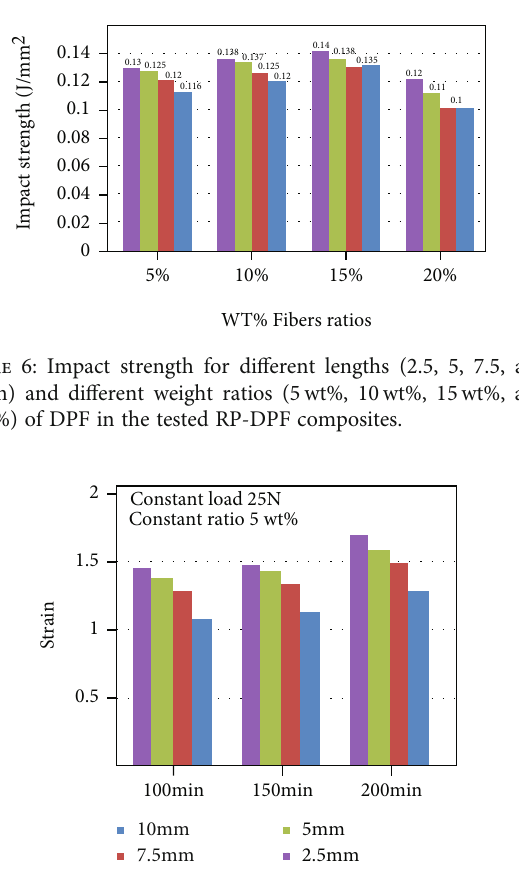
Figure 7: Strain values of RP-DPF composites for di ff erent lengths with constant weight ratio of 5 wt% and constant applied load of 25N for di ff erent strain times.